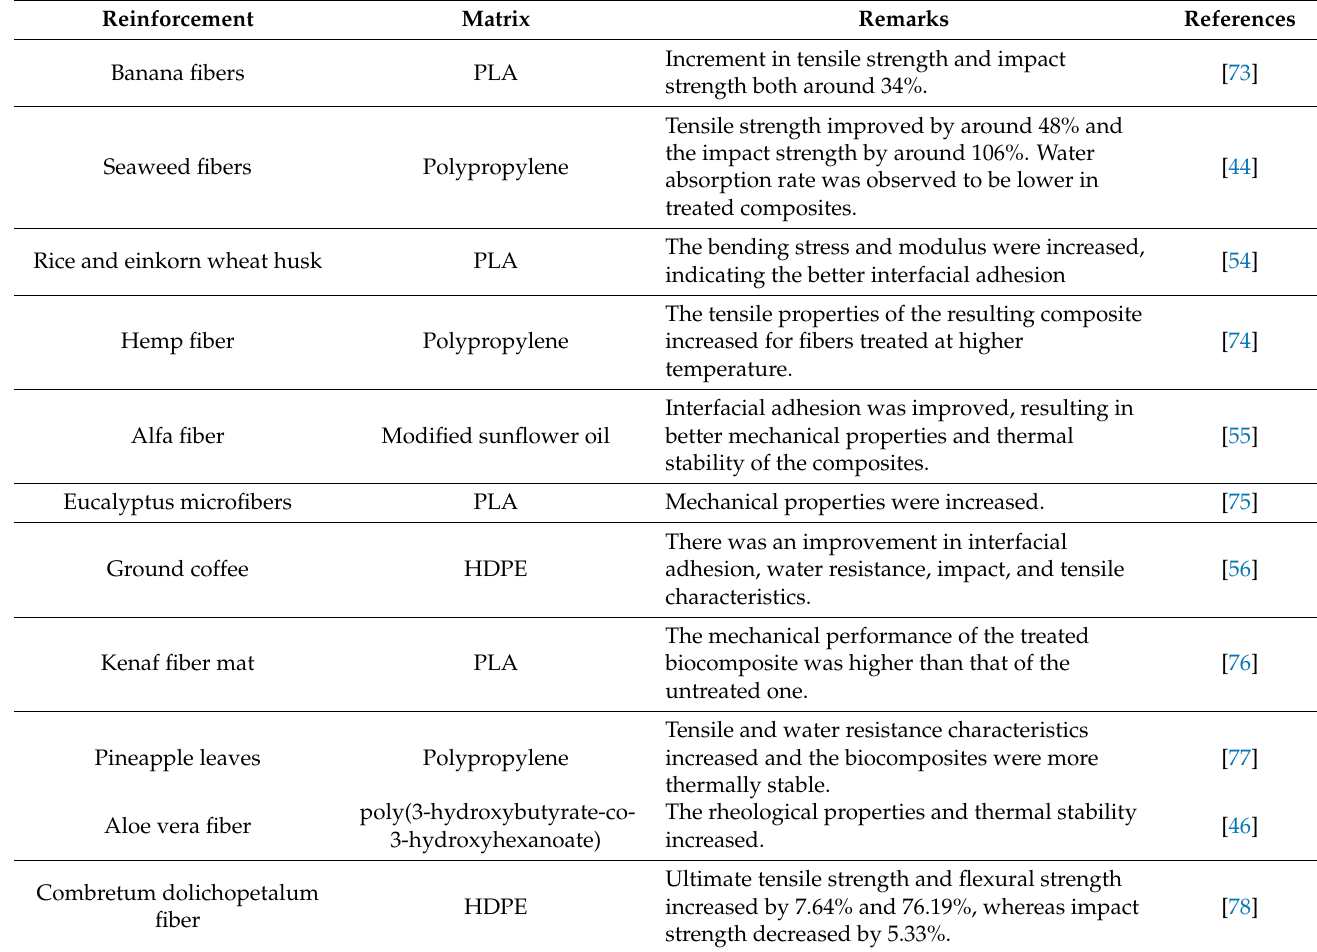
Table 3. Effect of alkaline